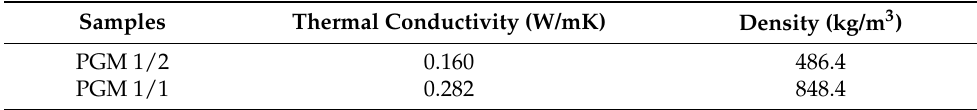
Table 6. Thermal conductivity and density of PGM 1/2 and 1/1.